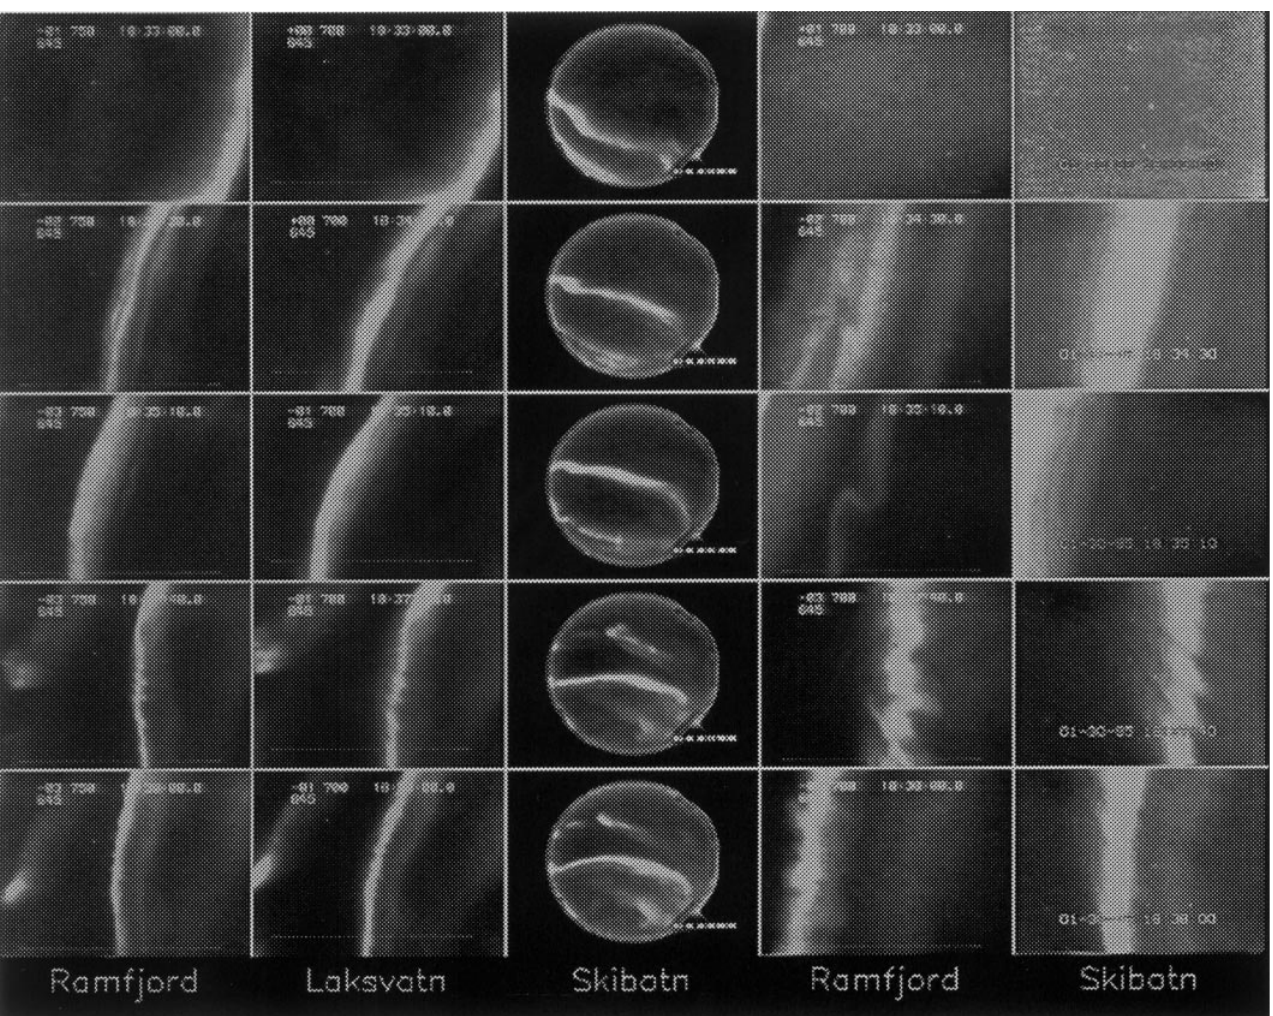
Fig. 1. Pictures of the aurora taken by the cameras in Norway on 30 January 1995. Long-pass red filters were used for the cameras at Ramfjord and Laksvatn. The camera parameters are given in Table 1. The times are from top to bottom 1833:00, 1834:30, 1835:10, 1837:40, and